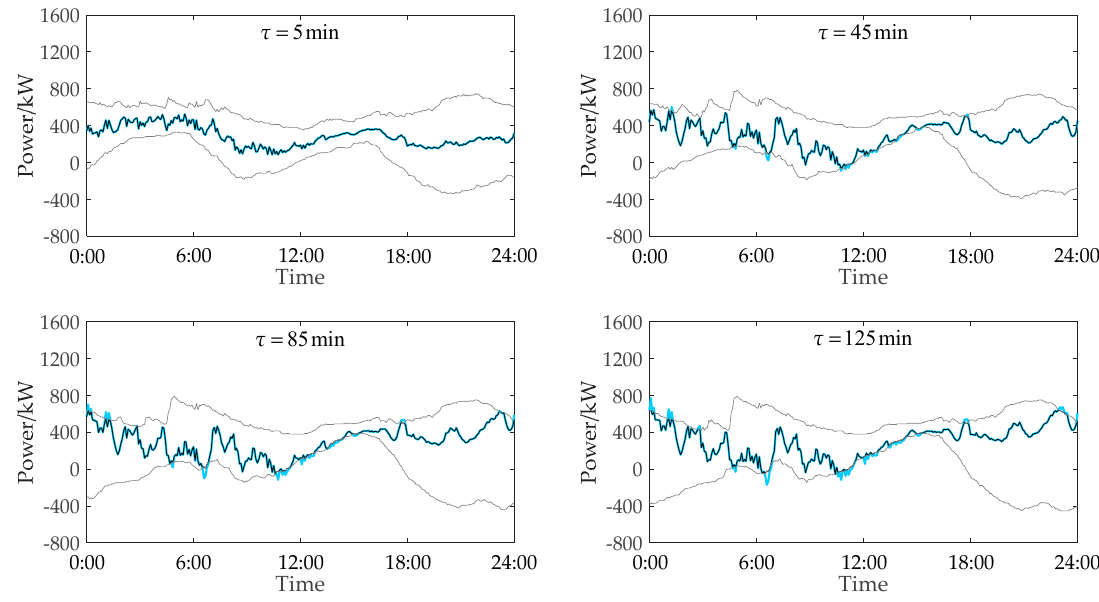
ff erent filter time